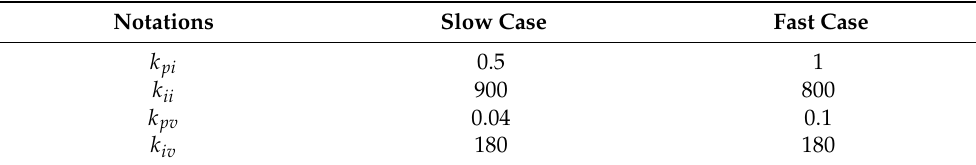
Table 4. PI control